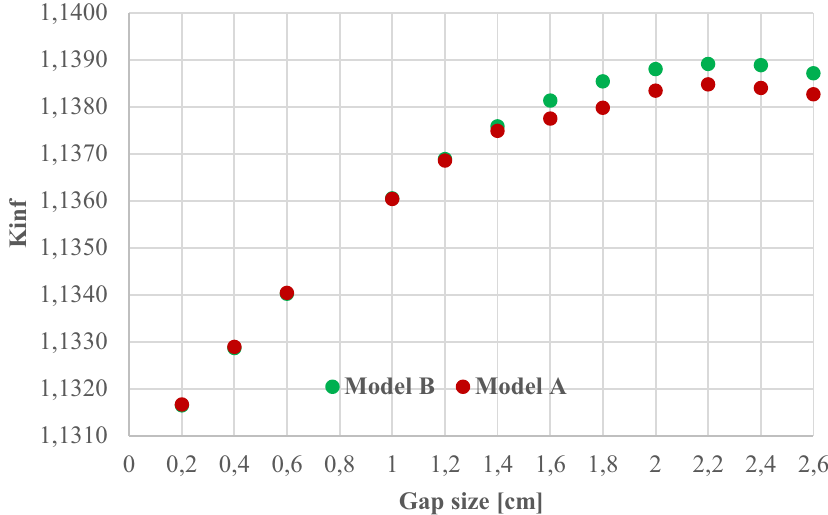
Figure 2. Multiplication factor of a MOX fuel assembly for different water gap size (moderator density = 711